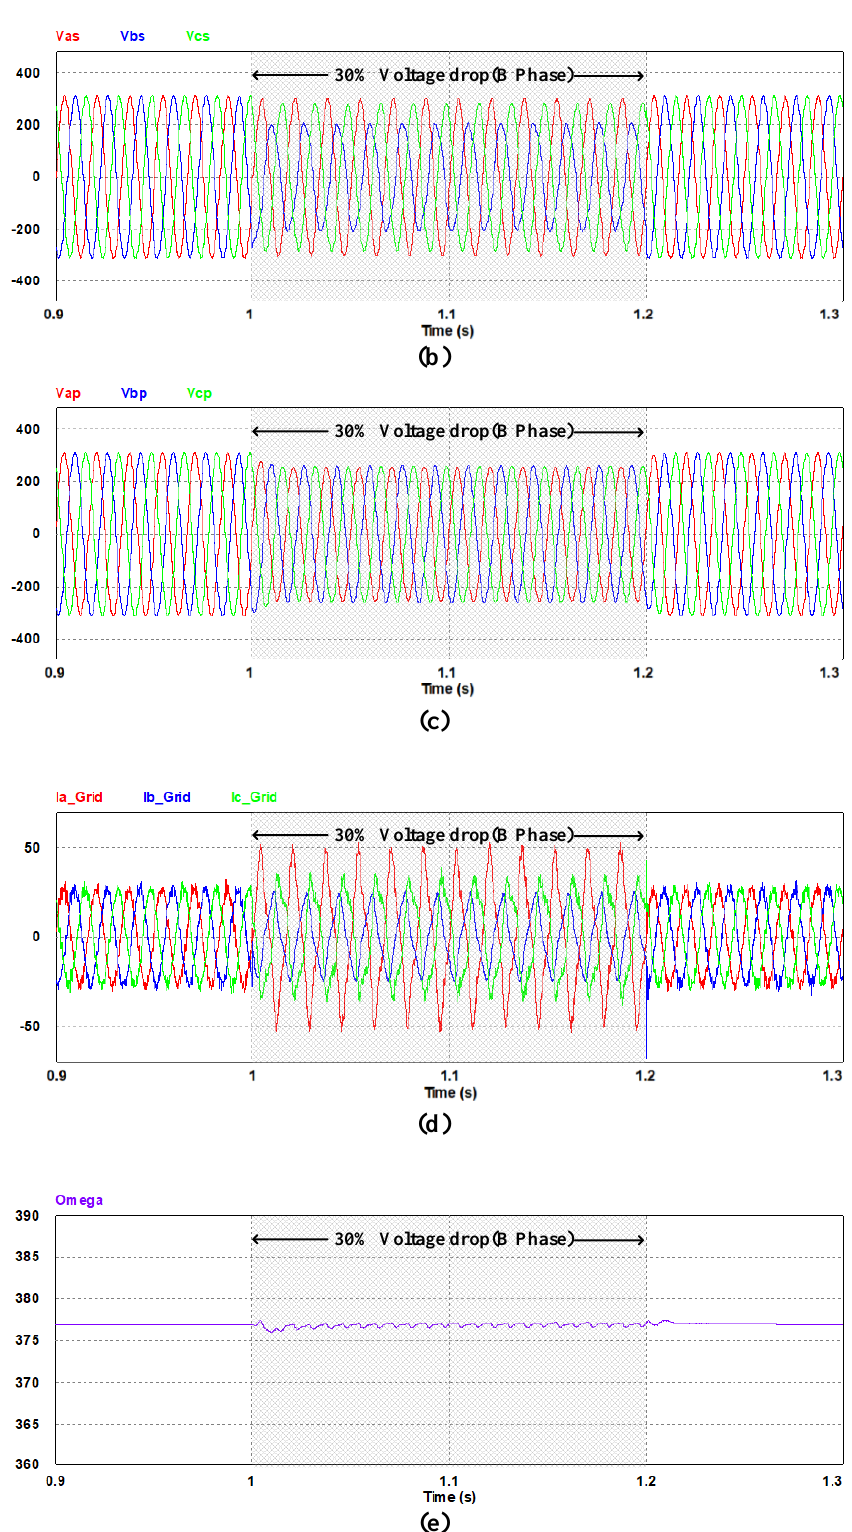
Figure 18. Waveforms of simulation results when b phase has a voltage drop; ( a ) the dc-link voltage; ( b ) the 3-phase input voltage with voltage unbalance; ( c ) the 3-phase input positive voltage detected by SOGI-FLL; ( d ) the 3-phase input current; and, ( e ) the center frequency extracted from SOGI-FLL.